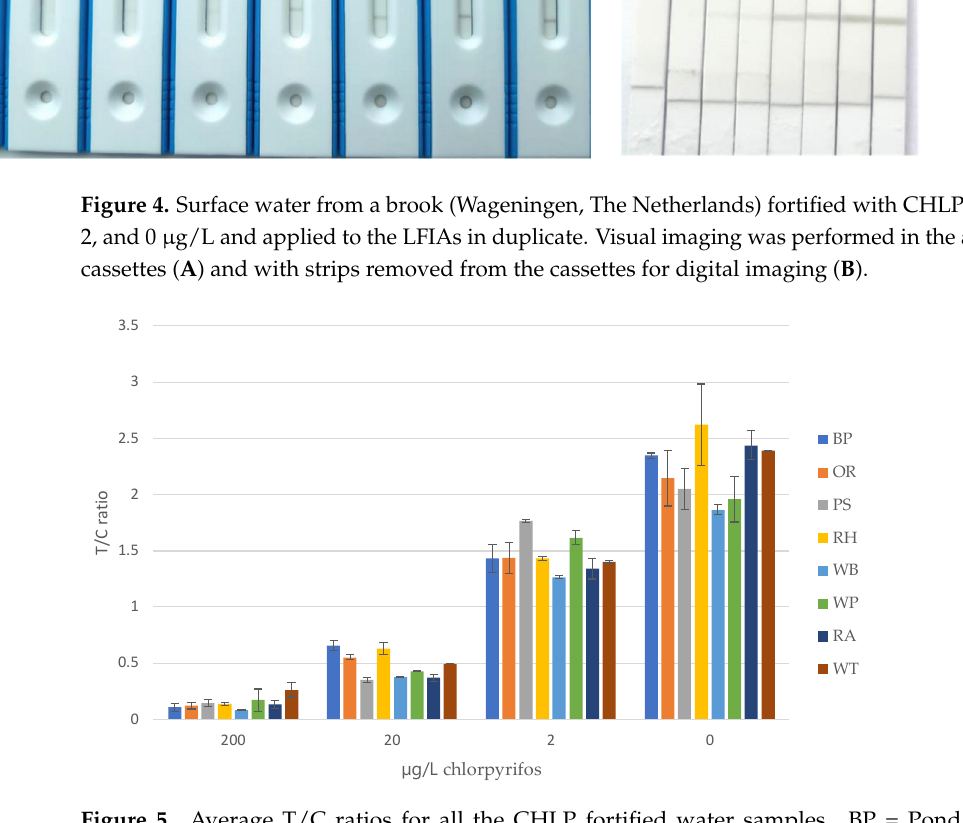
Figure 5. Average T/C ratios for all the CHLP fortified water samples. BP = Pond, Brussels; OR = Rhine, Oosterbeek; PS = Seine, Paris; RH = Harbor, Rotterdam; WB = Brooke, Wageningen; WP = Pond, Wageningen; AQ = aquaponics water, Rome; and T = tap water. Decision levels on the presence of low CHLP contaminations in surface waters